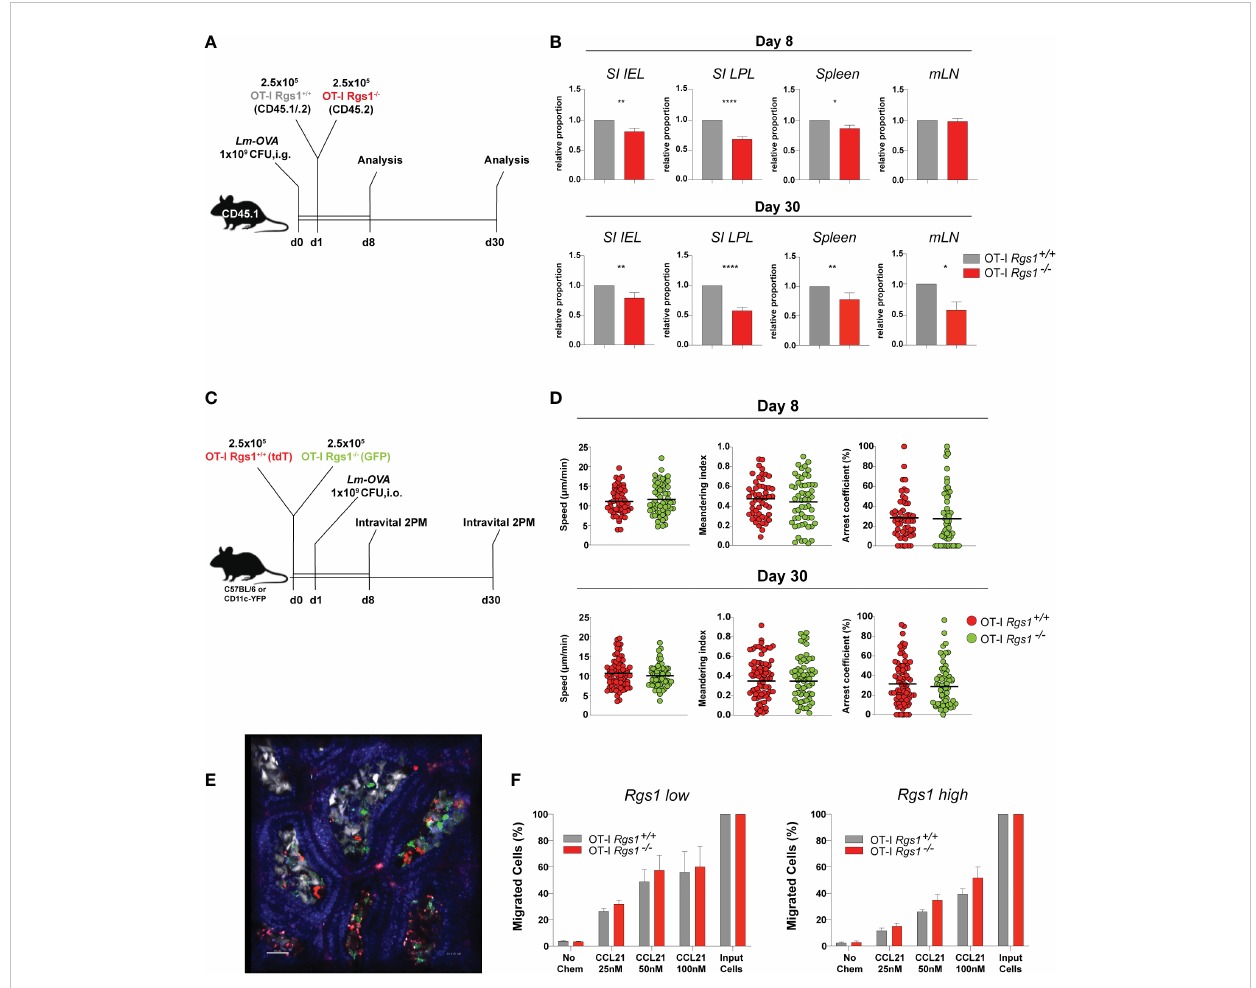
the emigration of antigen-speci fi c CD8 T cells out of the intestinal mucosa and draining lymph nodes. As shown in Supplementary Figure 7, CCR7 which can mediate emigration of T cells out of mucosal sites (32) and which is desensitized by the activity of Rgs1 (51) is upregulated in naïve OT-I T cells upon anti-CD3/28 activation under Rgs1 -inducing conditions. When activated OT-I Rgs1 +/+ vs . OT-I Rgs1 -/- cells were assayed for their chemotactic migration towards CCR7 ligand CCL21/exodus-2 in a transwell assay, OT-I cells migrated in a dose-dependent manner along the CCL21 gradient. A trend for higher chemotactic activity was